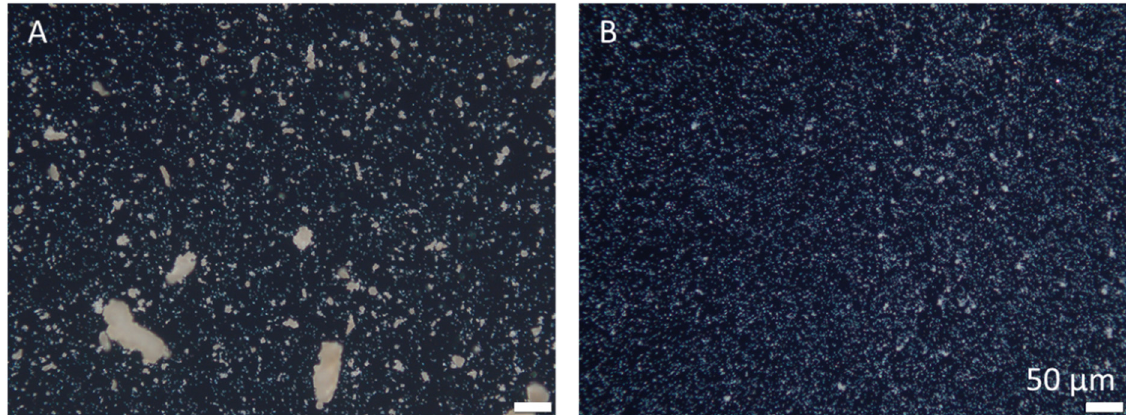
Figure 3. Microscopic images of the TiO 2 /water dispersion ( A ) and the TiO 2 /surfactant dispersion ( B ). Images were taken with the polarization filter and with a 200-fold magnification.